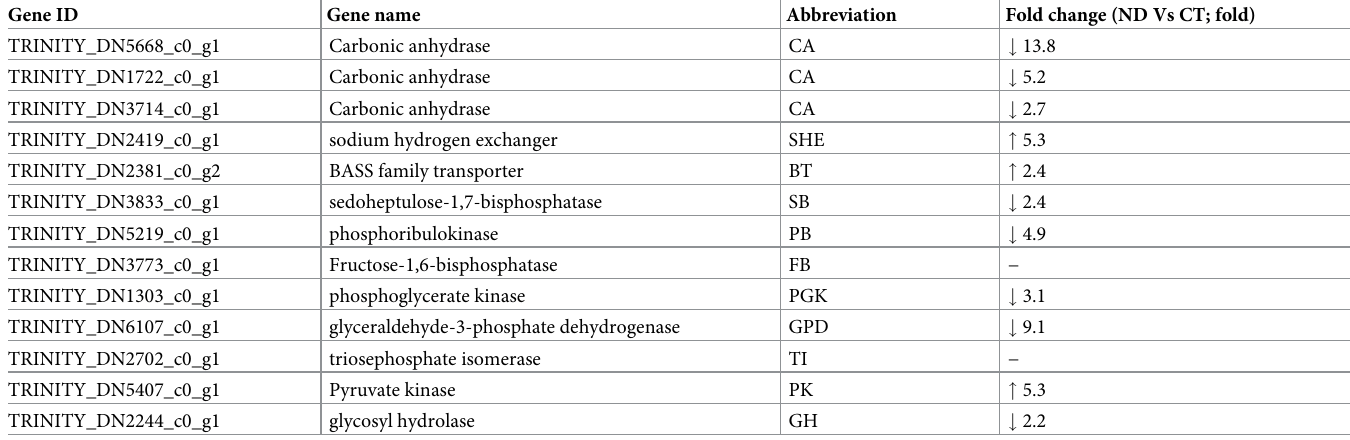
Table 3. Differential gene expression participated in carbon metabolism in P . cruentum